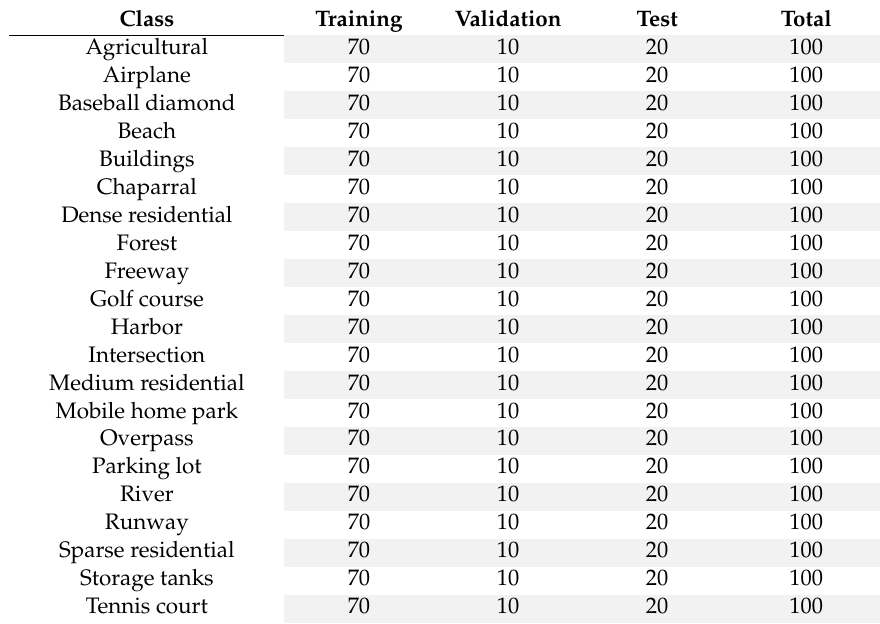
Table 1. Number of samples for training, validation, and test used for the University of California Merced land use (UCMerced)